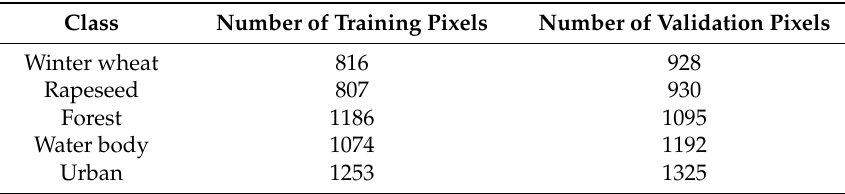
Table 2. Numbers of pixels per class for the training and validation